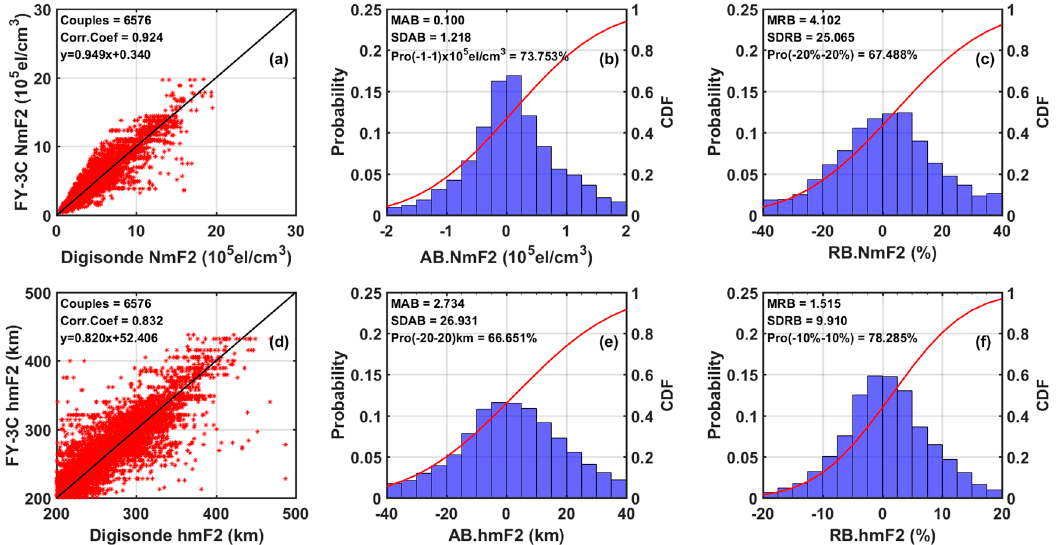
Figure 7. The comparison of FY-3C RO-derived ICPs with ICPs derived from digisonde during 2014–2017 based on the collocation space and time windows of (3°, 5°, 1 h) for the statistical parameters of ( a, d ) correlation coefficients, ( b, e ) absolute biases, and ( c, f ) relative biases.